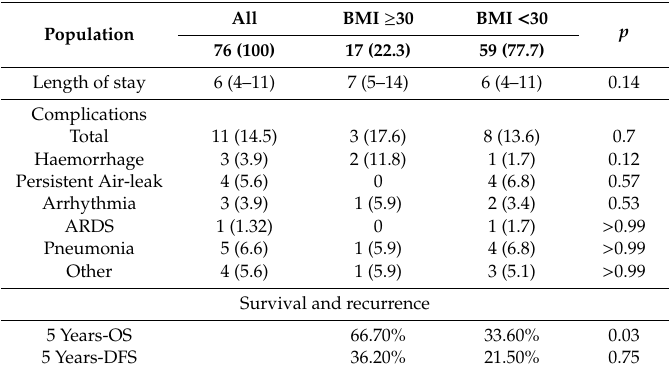
Table 3. Complications and